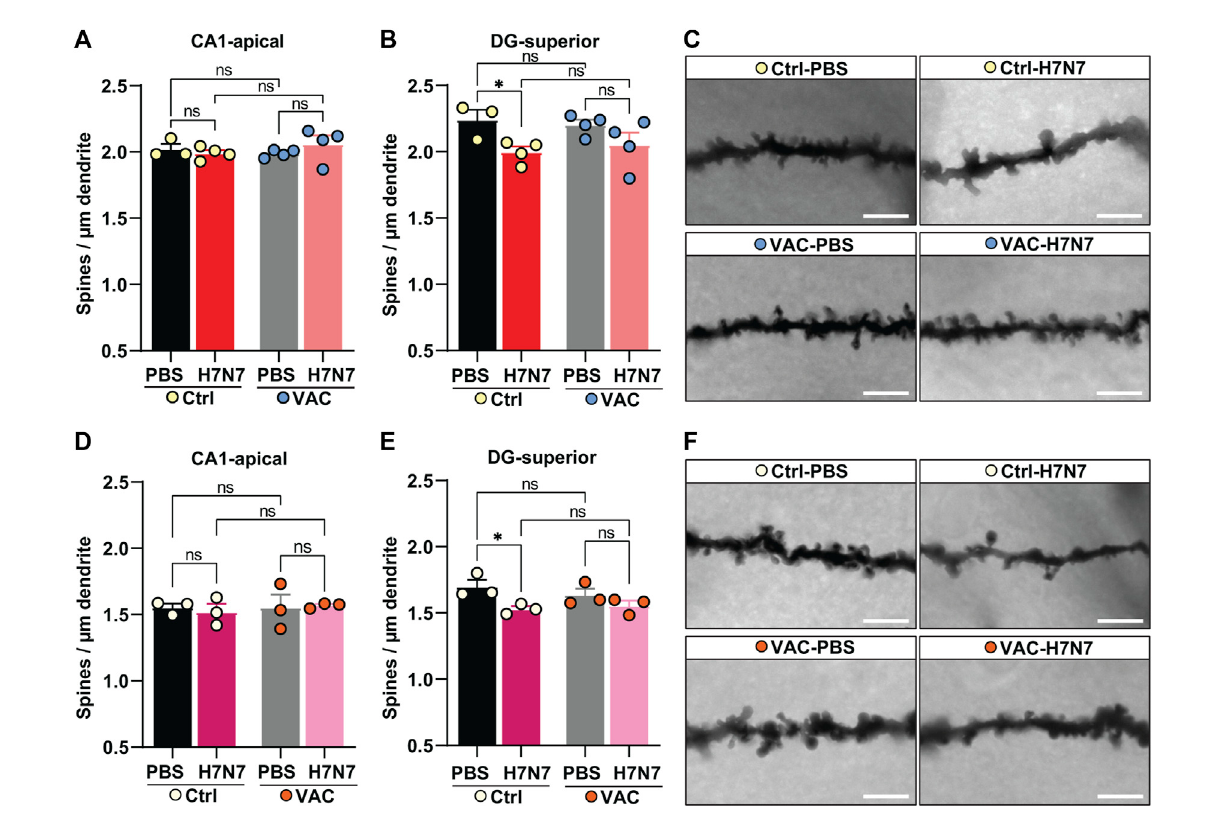
FIGURE 6 Effects ofvaccinationon hippocampal neuronmorphology changes causedbyH7N7IAVinfection. Inyoung mice (A) thedensity ofdendriticspines in the CA1 subregion of the hippocampus did not change signi fi cantly 8 days after infection with the H7N7 IAV in unvaccinated mice compared with the correspondingcontrolgroup. Thiswasalso thecaseinvaccinatedmice. Vaccinationitselfdidnot causethesigni fi cantchanges indendriticspine density in CA1. (B) Infection with the H7N7 IAV resulted in a signi fi cant reduction in dendritic spine density in the dentate gyrus subregion in unvaccinated mice compared with the control group. This signi fi cant reduction was not observed after H7N7 IAV infection in previously vaccinated mice. Vaccination itselfdidnot induce thesigni fi cant changes indendriticspine density inDG ( n = 3 – 4animals per group). (C) Representative images of Golgi-Cox staining showingdendritesofgranulecellsinthe dentategyrussuperior subregionofallexperimentalgroupsofyoungmice(63X);scale=5 μ m.Inagedmice (D) , the dendritic spine density in the CA1 subregion of the hippocampus did not change signi fi cantly 10 days after infection with the H7N7 IAV in unvaccinated mice compared to the corresponding control group. This was also the case in vaccinated mice. Vaccination itself did not cause the signi fi cant changes in dendritic spine density in CA1. (E) Infection with the H7N7 IAV resulted in a signi fi cant reduction in dendritic spine density in the superior subregion of the dentate gyrus in unvaccinated mice compared to controls. This signi fi cant reduction was not observed after H7N7 IAV challengeinpreviouslyvaccinatedmice.Vaccinationitselfdidnotleadtosigni fi cantchangesindendriticspinedensityinDG( n =3animalspergroup). (F) Representative Golgi-Cox staining images showing dendrites of granule cells in the superior dentate gyrus subregion of all experimental groups of old mice (63X); Scale = 5 µm. Data are presented as mean ± SEM and were analyzed with an ordinary two-way ANOVA followed by Fisher ’ s LSD test; * p <